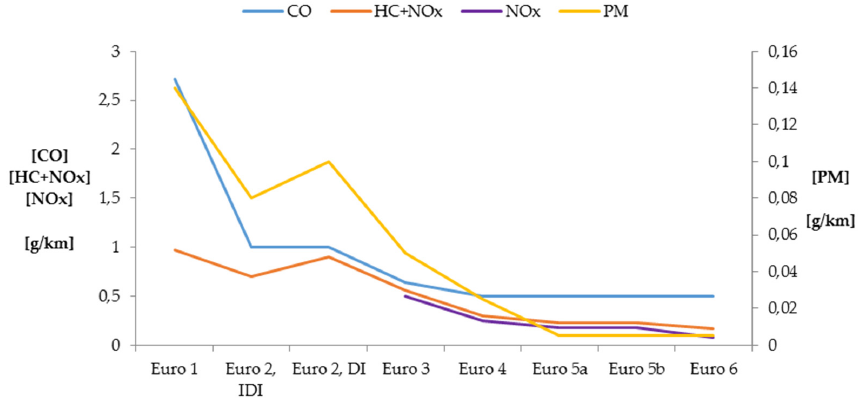
Figure 1. The Euro emission standards for the regulated diesel car pollutants (based on [16]).